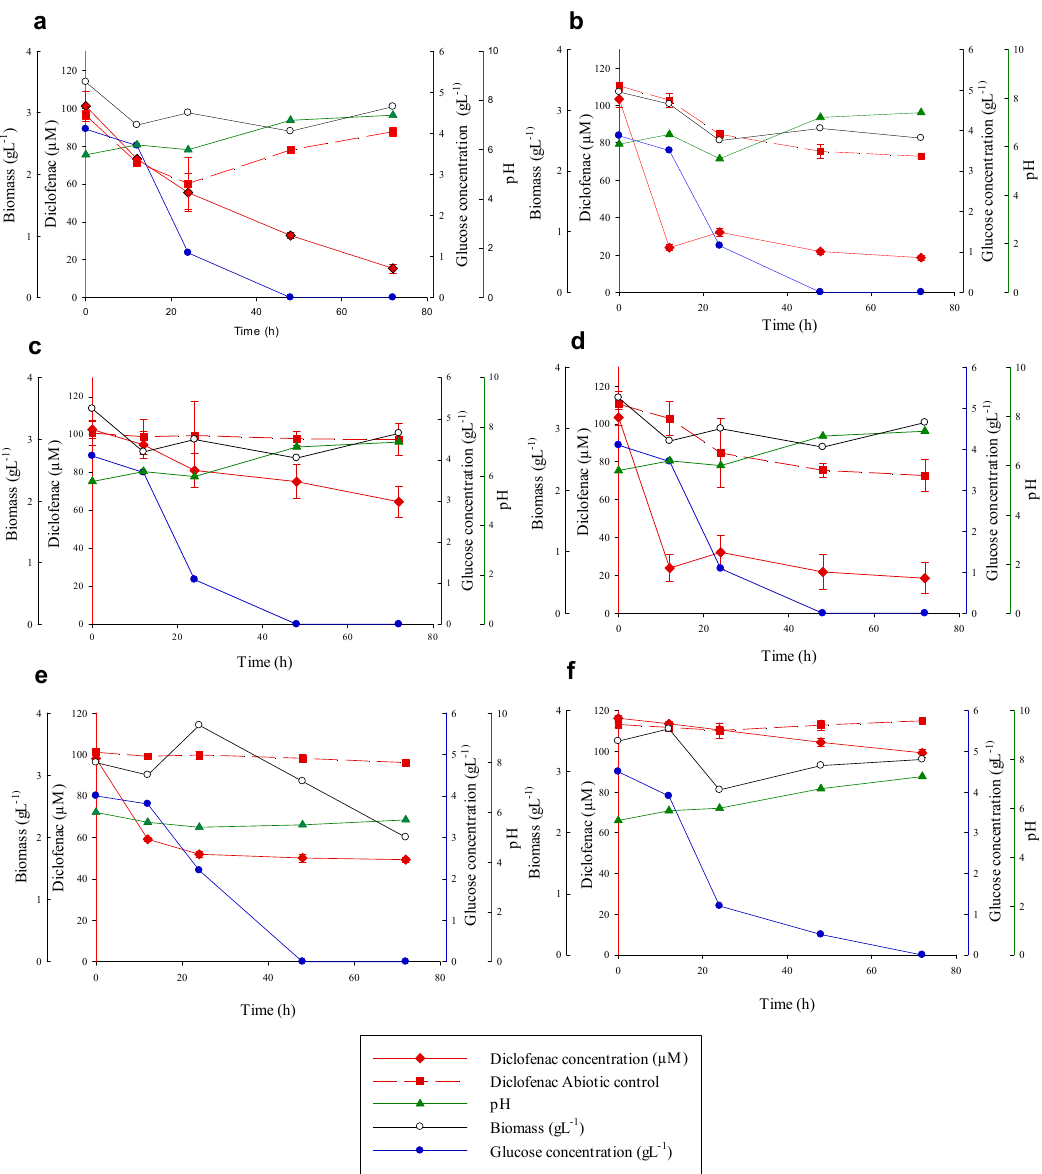
Figure 2. Comparison of diclofenac elimination by Talaromyces gossypii ( a ), Syncephalastrum 324 monosporum ( b ), Aspergillus tabacinus ( c ), Talaromyces verruculosus ( d ), Aspergillus terreus ( e ), 325 Aspergillus cejpii ( f ). Diclofenac concentration (red diamond), glucose concentration (blue cir- 326 cles), pH (green triangle), biomass (white circles) and the diclofenac abiotic control (red 327 square) were measured. Error bars represent standard deviation of three independent repli- 328 cates . 329